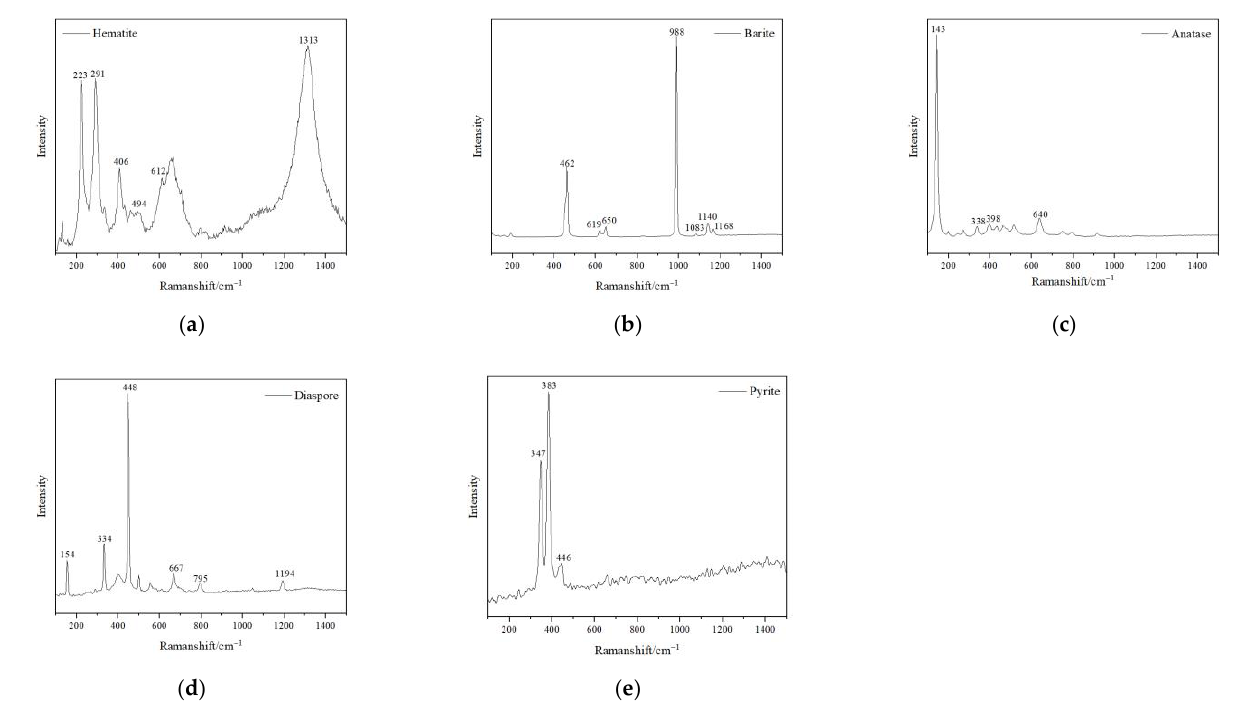
Figure 4. Raman Spectra of impurity minerals in the samples. ( a ) hematite detected from the red